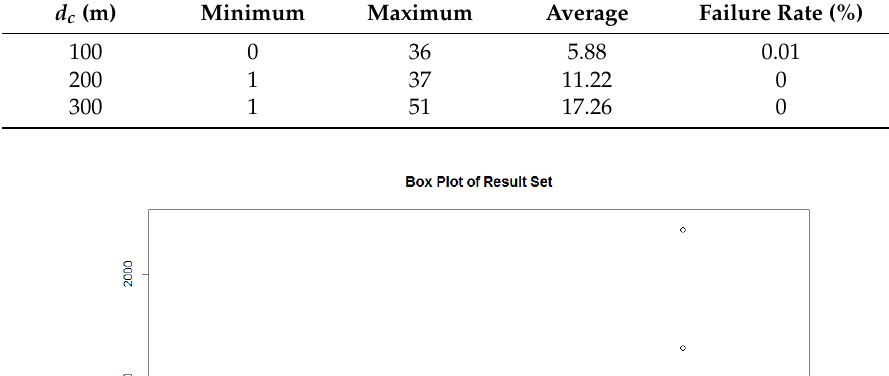
Table 2. The number of response user.